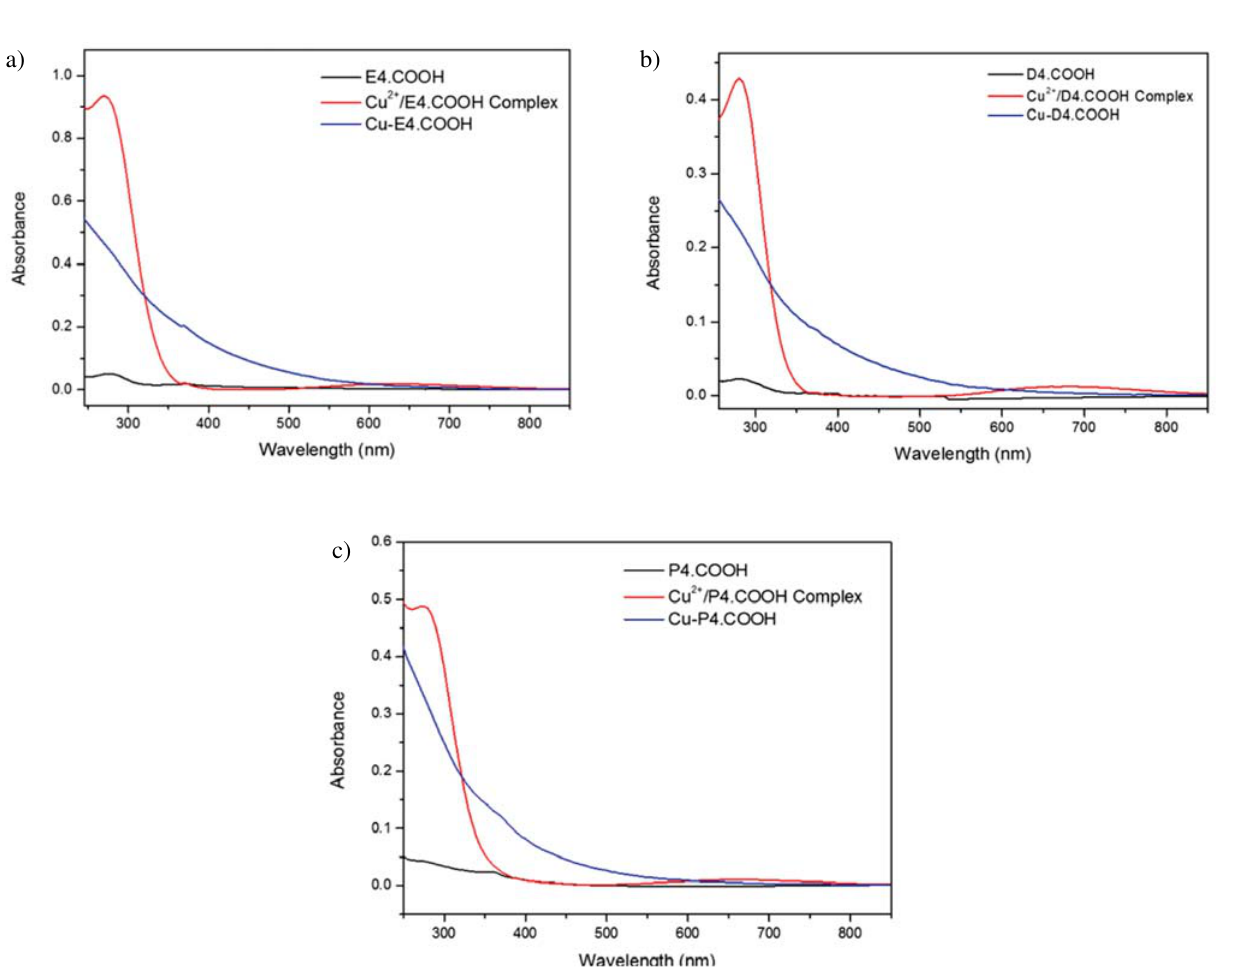
tial monotically increasing spectrum towards to shorter wavelengths (Figure 7, 8). Moreover, the size of Cu clu- sters can be understood from the absence of a Mie pla- sman peak at around 570 nm in UV-Vis spectra (Figure 8).